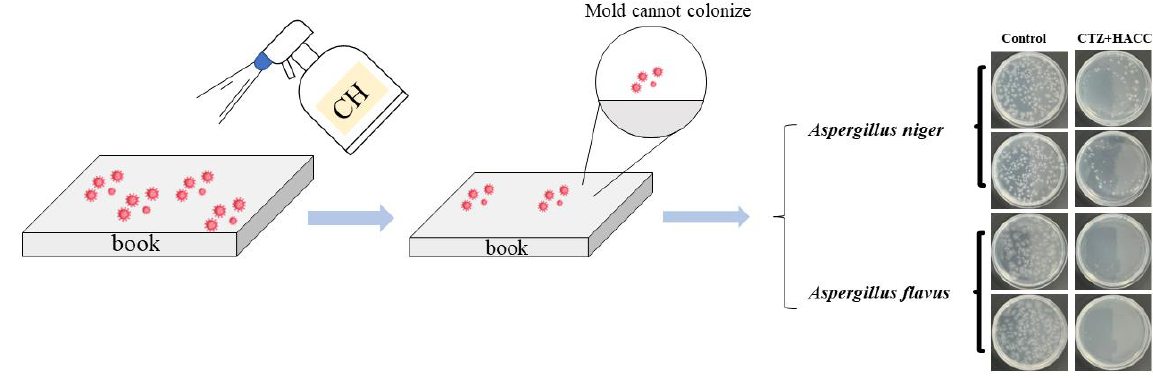
Figure 1. Schematic illustration of the antifungal effect of microemulsion formulations.